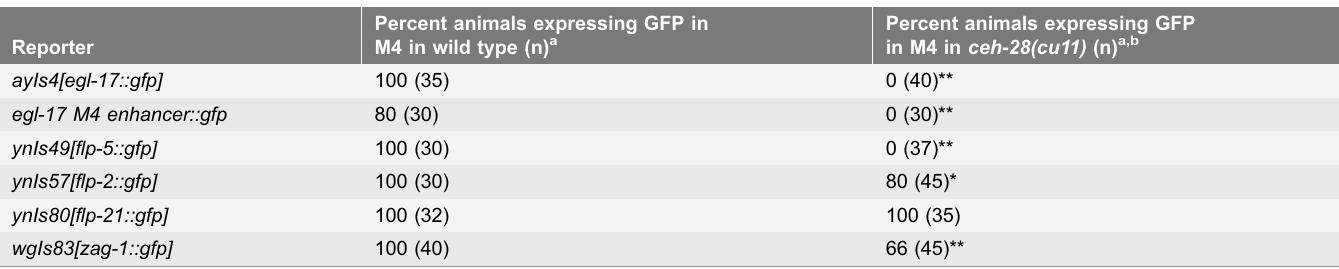
Table 1. Frequency of animals expressing GFP in M4 in wild-type and ceh-28 mutants.